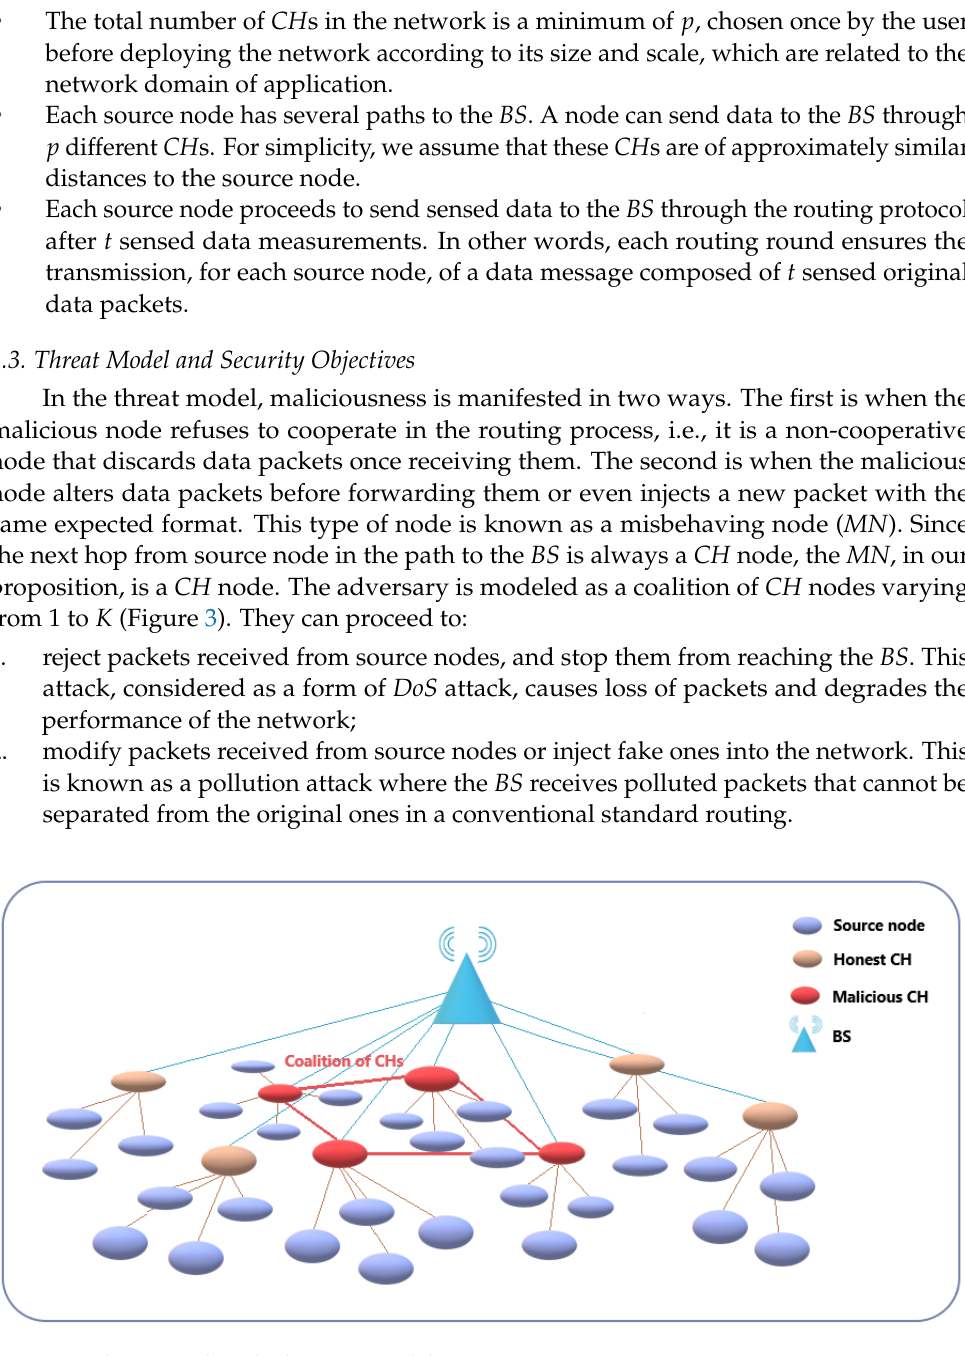
Figure 3. The network and adversary